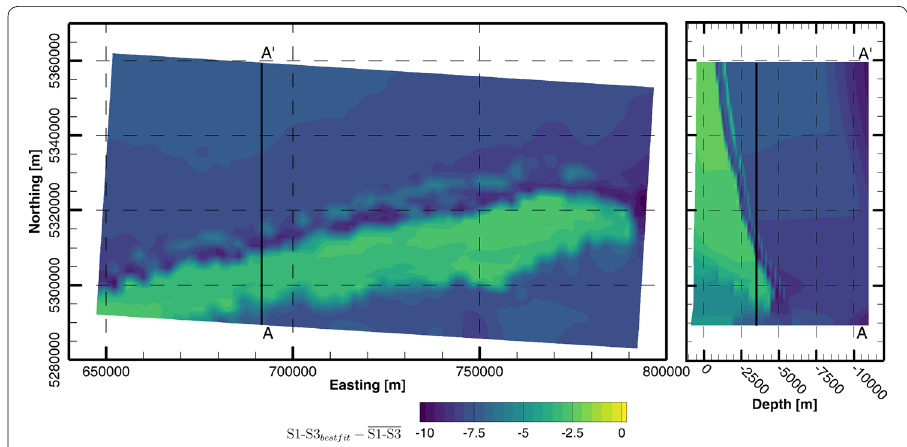
Fig. 7 Difference between the differential stress S 1 – S 3 from the best‑fit model scenario and the average of the modelled S 1 – S 3 results of all 36 model scenarios on a horizontal plane in a depth of 3500 m below sealevel (left) and on the profile A – A ′ (right) with a vertical exaggeration of 1:4. In the profile, the depth of 3500 m is indicated by a bold black